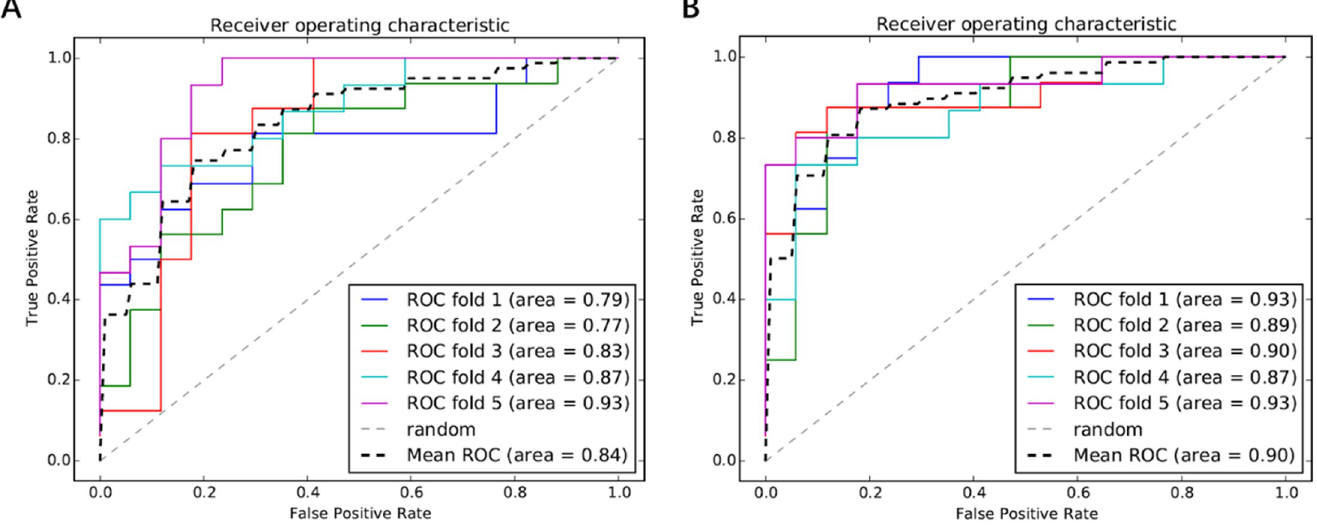
Fig 6. ROC curves for evaluating the performance of the SVM classifier. A: ROC curves without clinical features, 1–4 is training set and 5 is test set; B: ROC curves with clinical features, 1–4 is training set and 5 is test set.